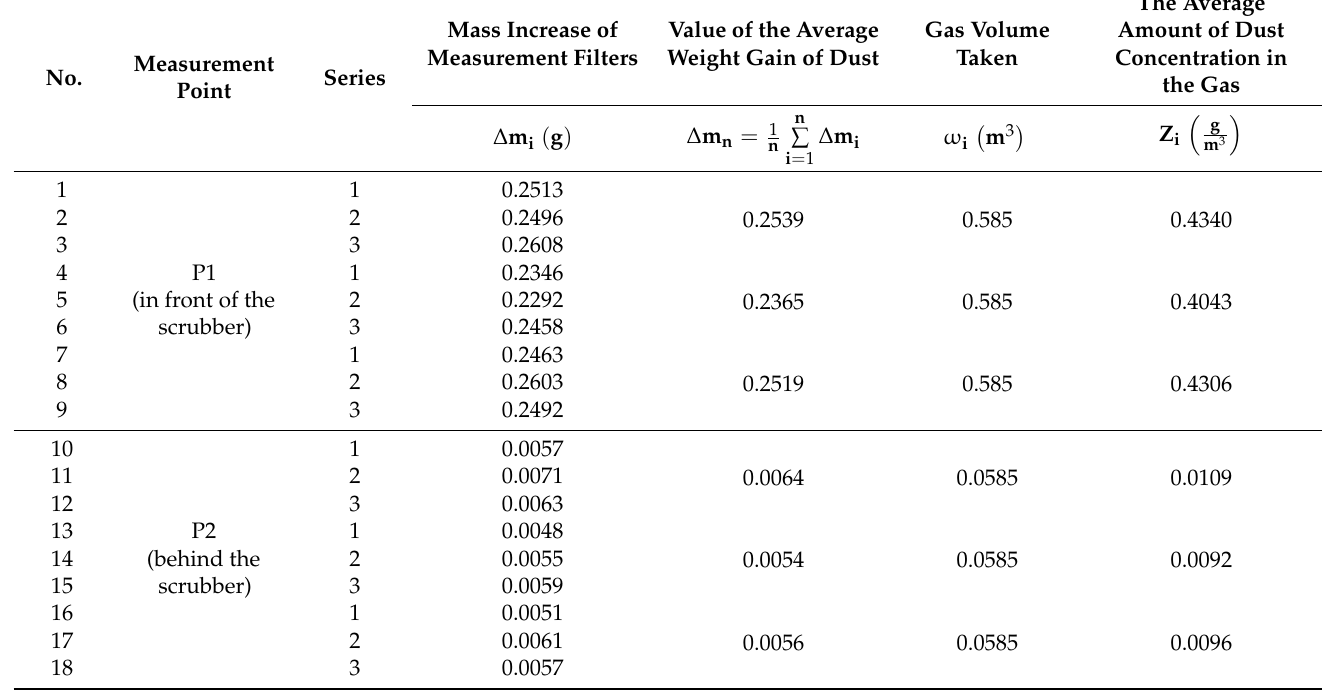
Table 2. Dimensions of machines and devices with minimum movement